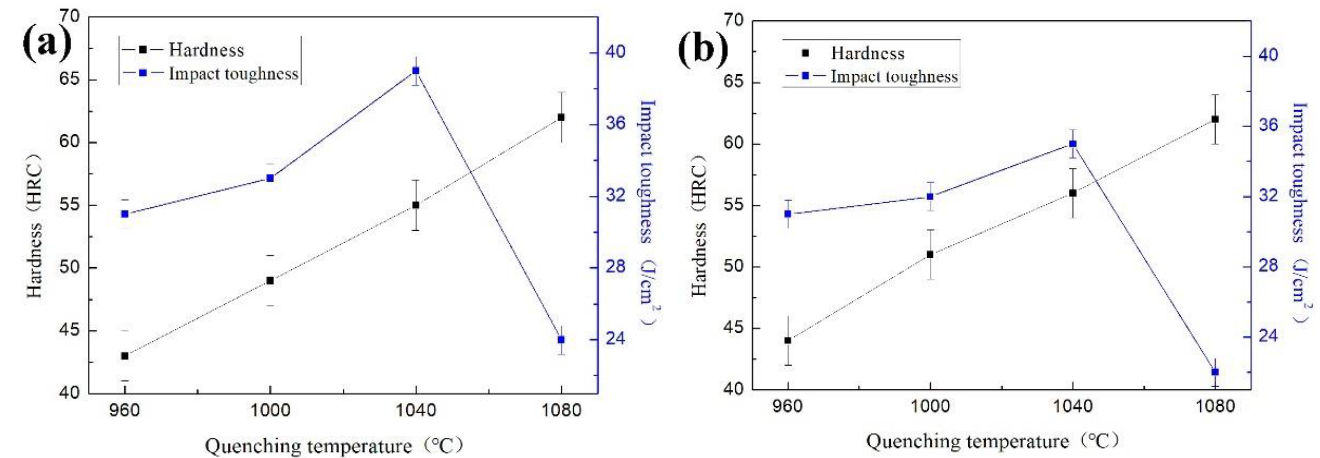
Figure 8. Hardness and impact toughness of alloy steel: ( a ) alloy A; ( b ) alloy